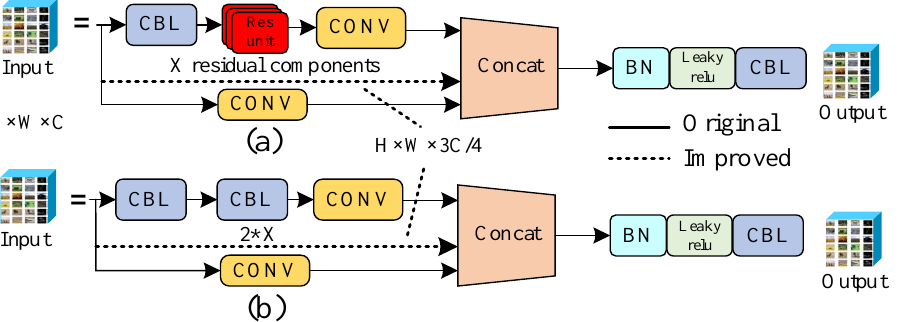
Figure 5. ( a ) The network structure of improved BottleNeckCSP_1 module.; ( b ) The network struc- ture of improved BottleNeckCSP_2 module. of improved BottleNeckCSP_2